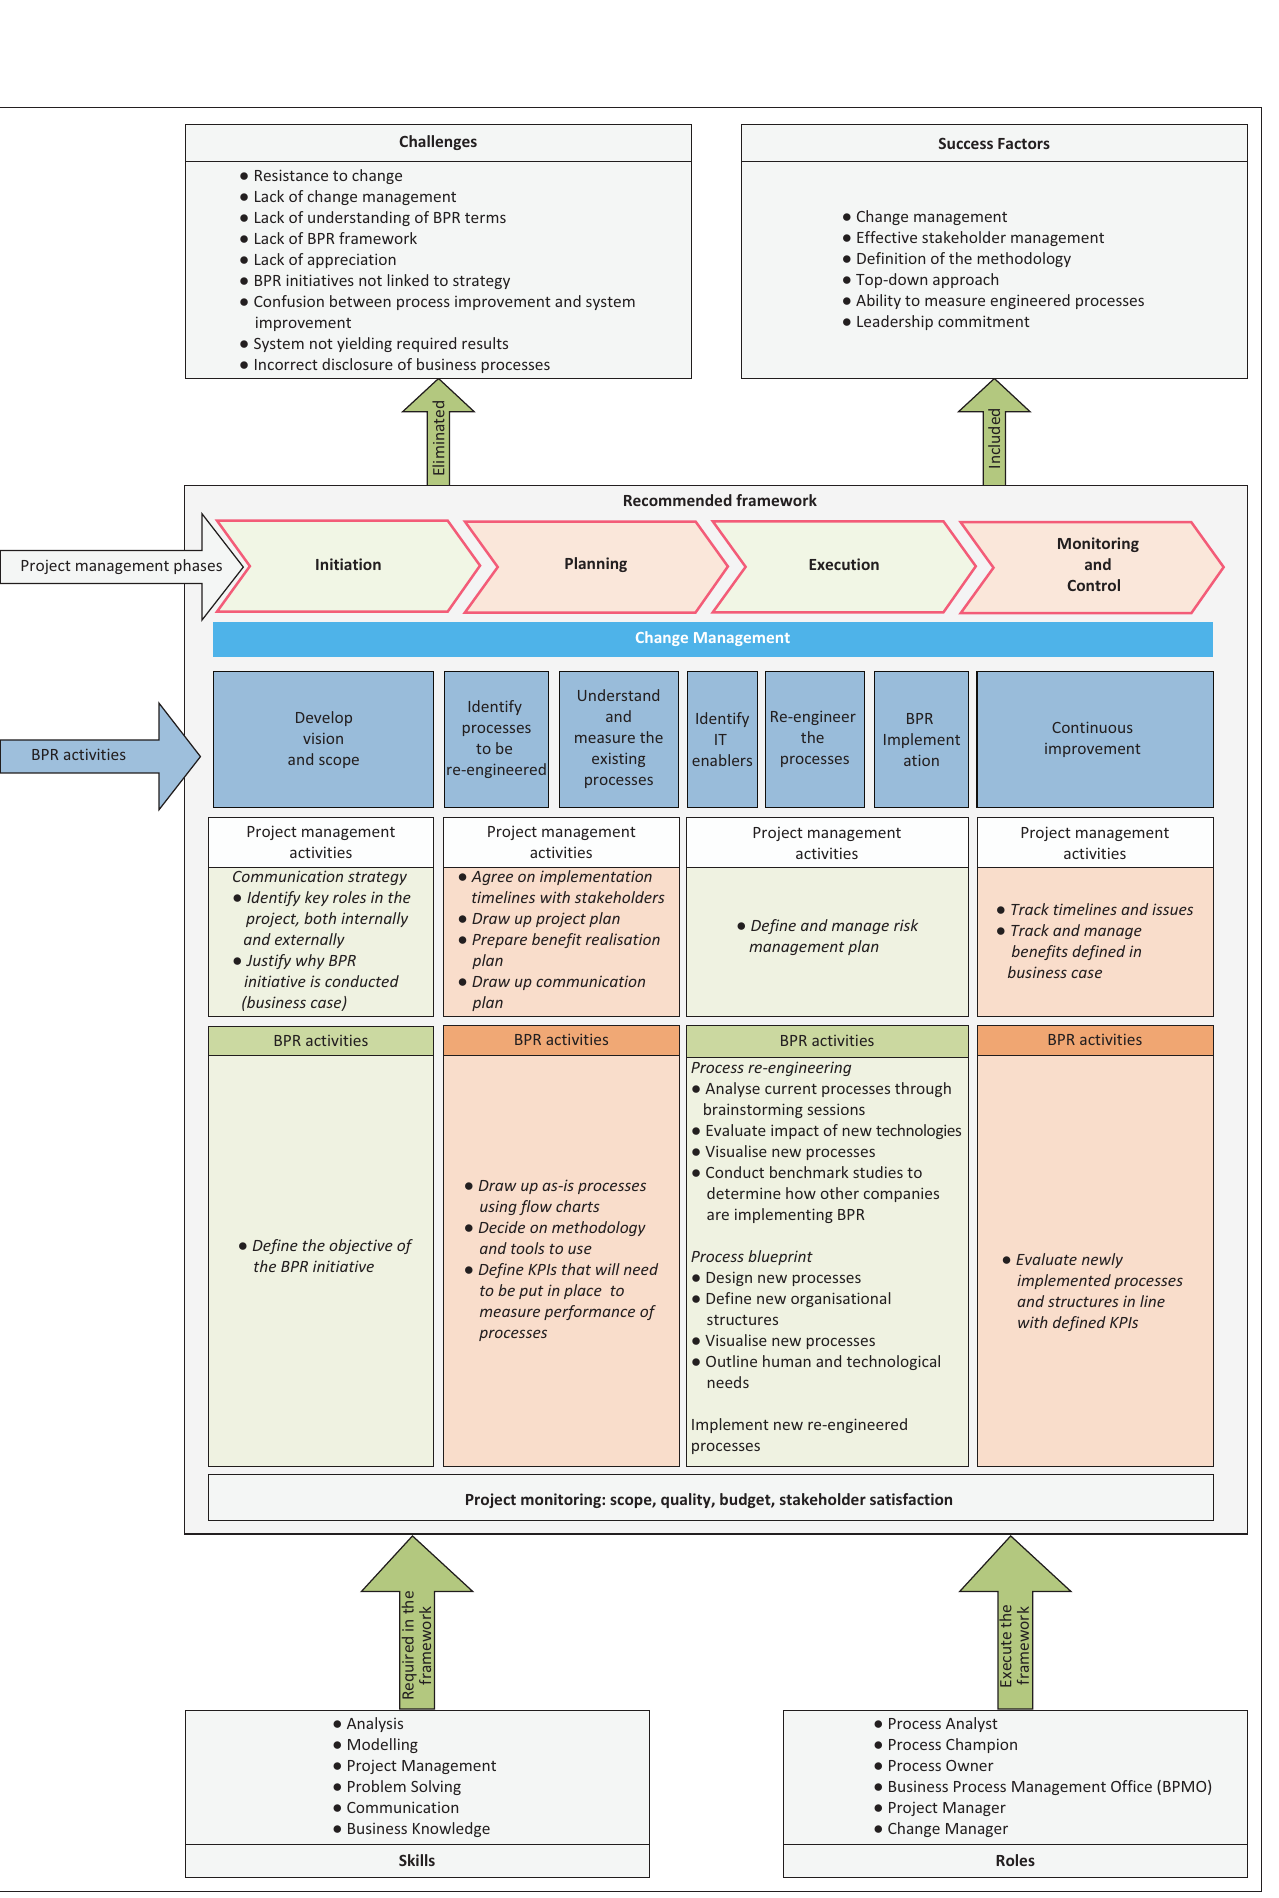
FIGURE 4: Conceptual business process re-engineering